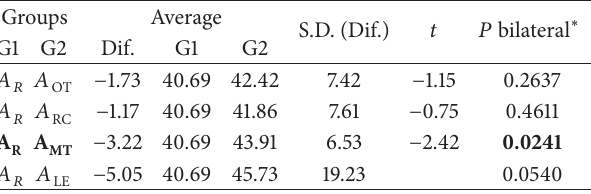
Table 2: Computational time (in minutes) for the calculation of soil area in binary images obtained by several thresholding methods: Otsu (OT), Ridler-Calvard (RC), local entropy (LE), manual thresholding (MT), and reference area ( 𝑅 ). This time has been estimated based on a set of 24 color images. The ratio has been calculated with respect to MT method.